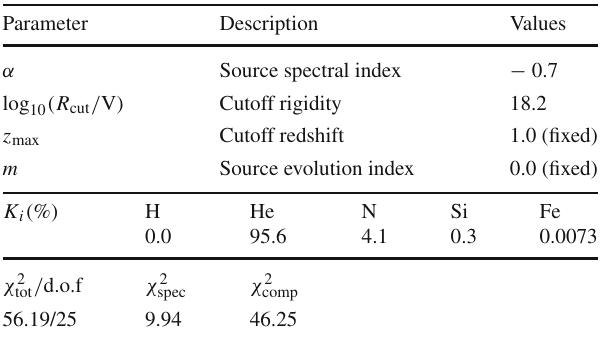
Table 1 UHECR best-fit parameter set for the one-population model (flat evolution, m =